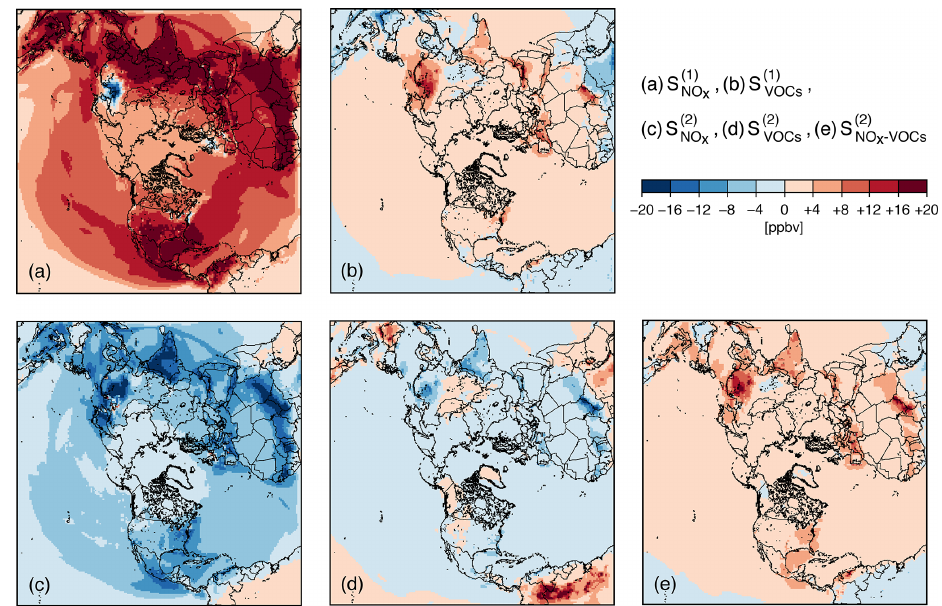
Figure 1. Spatial distribution of the sensitivity coefficients of O 3 to domain-wide emissions. (a) First-order sensitivity to NO x emissions, (b) first-order sensitivity to VOC emissions, panel (c) is the same as (a) but second order, panel (d) is the same as (b) but second order, and (e) second-order sensitivity to NO x and VOC emissions during April 2010. The sensitivity coefficients are monthly means computed from all hourly data on April 2010.